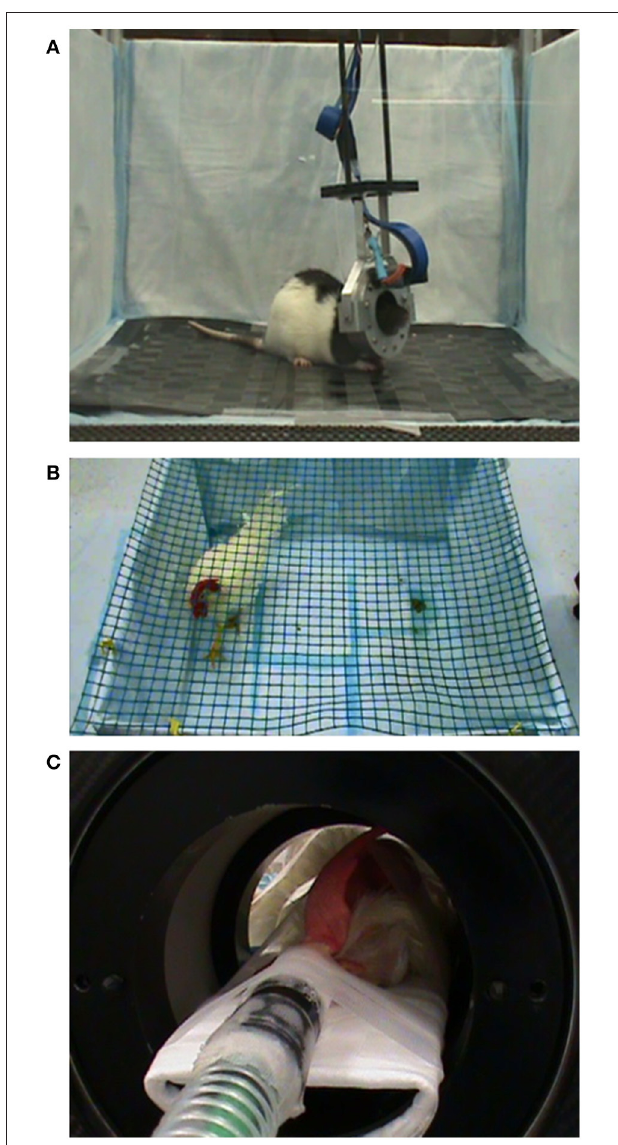
FIGURE 2 | Experimental setup during PET scanning. (A) A rat is imaged with the RatCAP scanner while it is awake and spontaneously behaving in an open field. (B) A chicken is traversing the pen during uptake of 18 F-FDG. (C) A chicken under isoflurane anesthesia during PET scanning in the